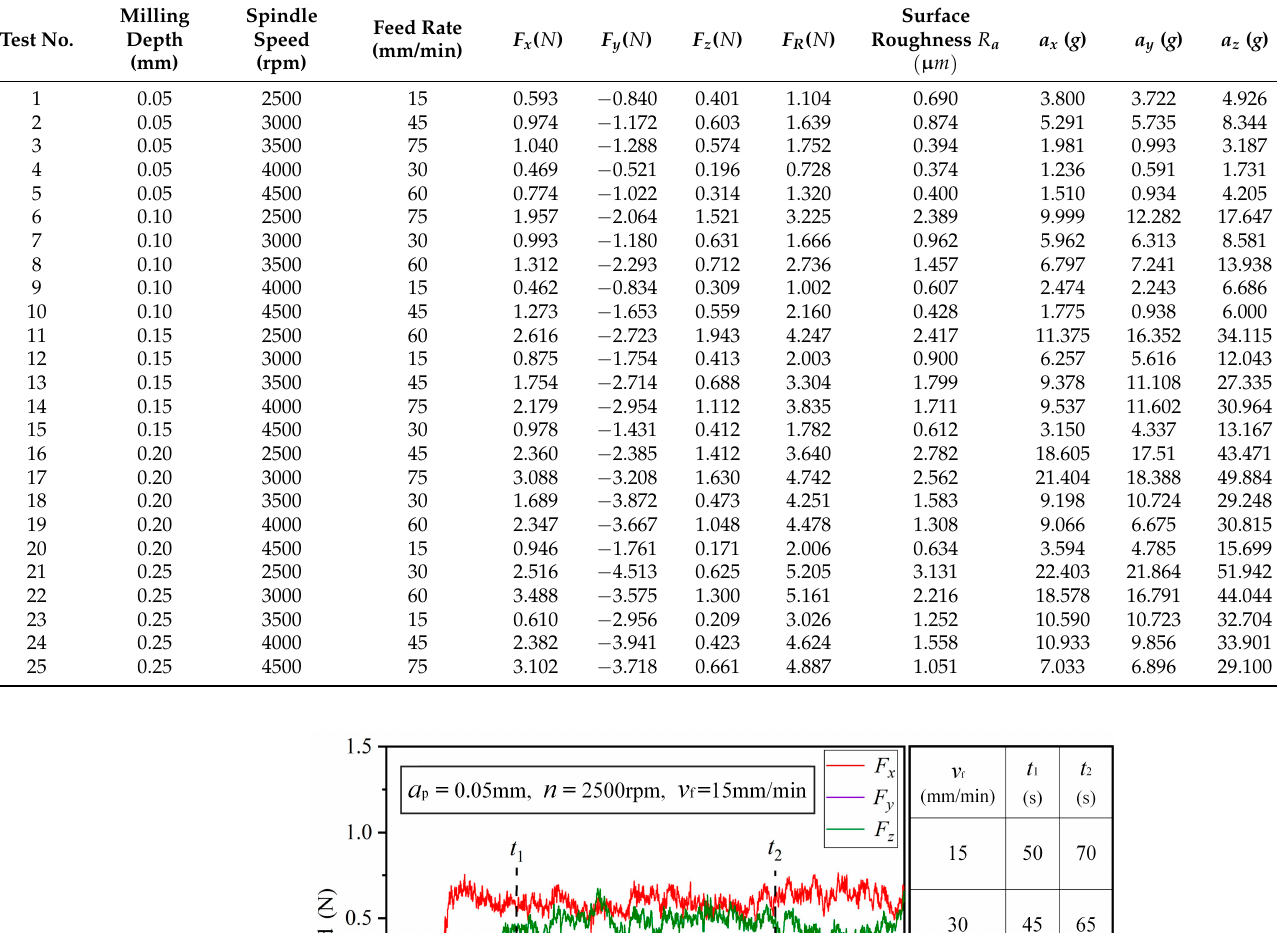
Table 5. Milling experiment results of 7075-T651 aluminum alloy.